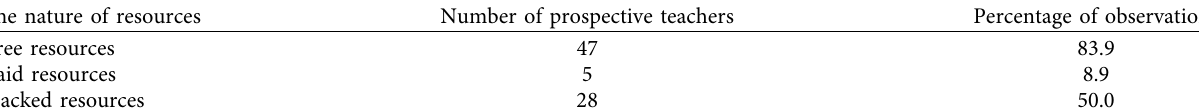
Table 9: The nature of the resource that dominates the digital practices of prospective teachers.